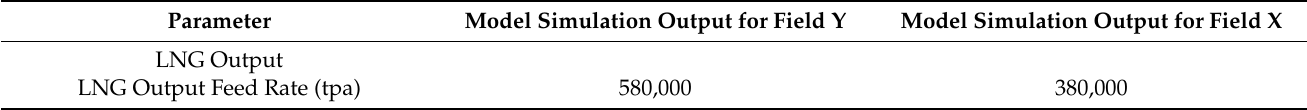
Table 8. LNG simulation output for Fields Y and